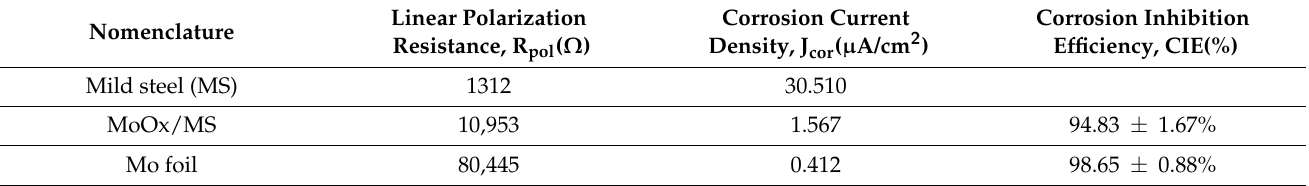
Table 1. Polarization resistance and corrosion current calculated from Tafel extrapolation and